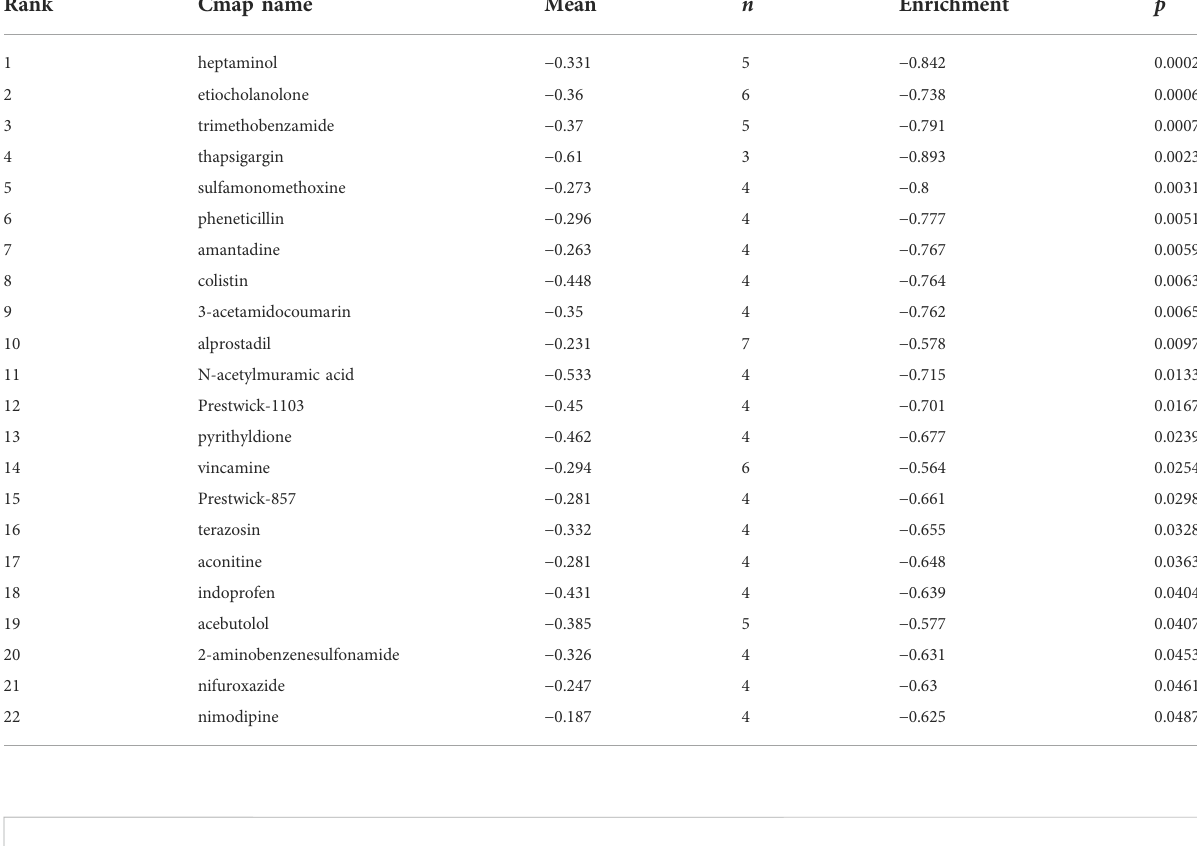
TABLE 2 The compounds screened that can reduce GC patients ’ risk.